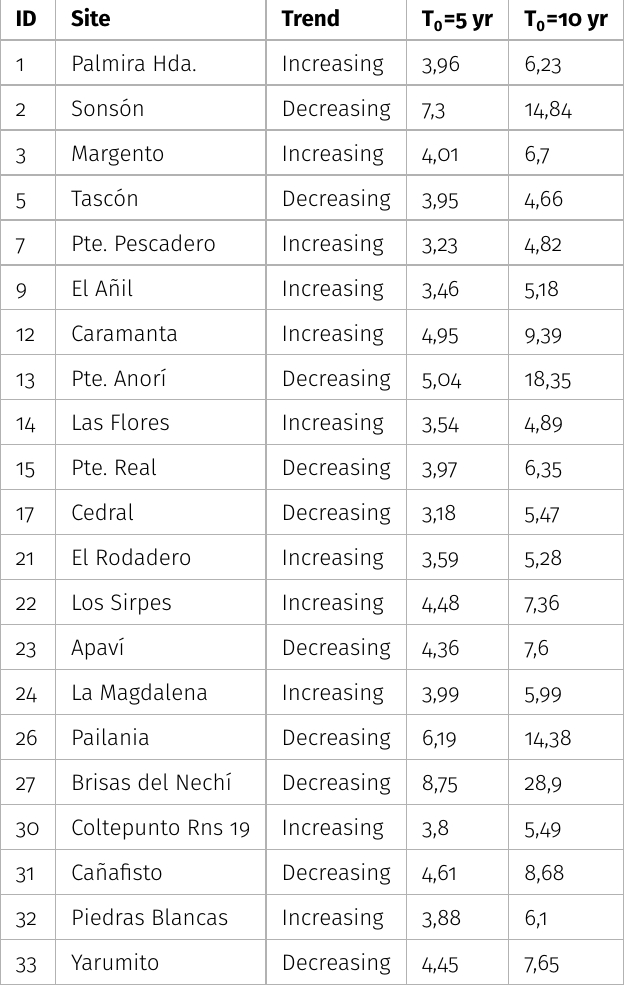
Table III. Variation of the return period in a non-stationary